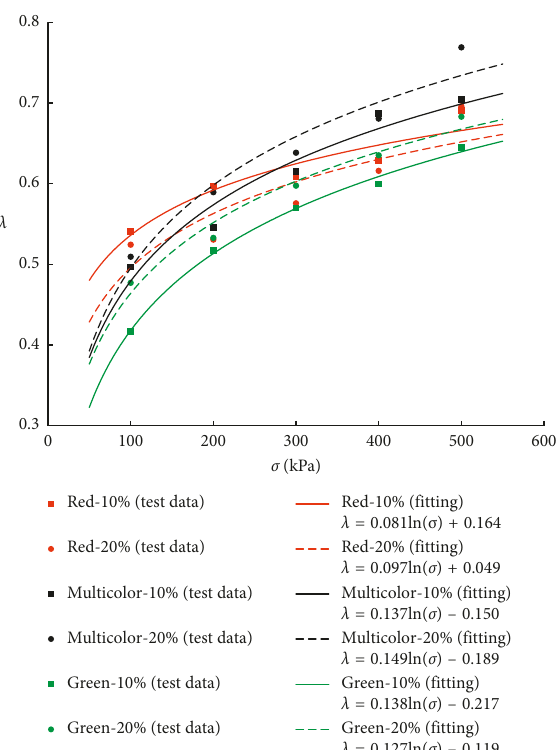
Figure 13: Fitting curves and fitting equations of λ value with σ .